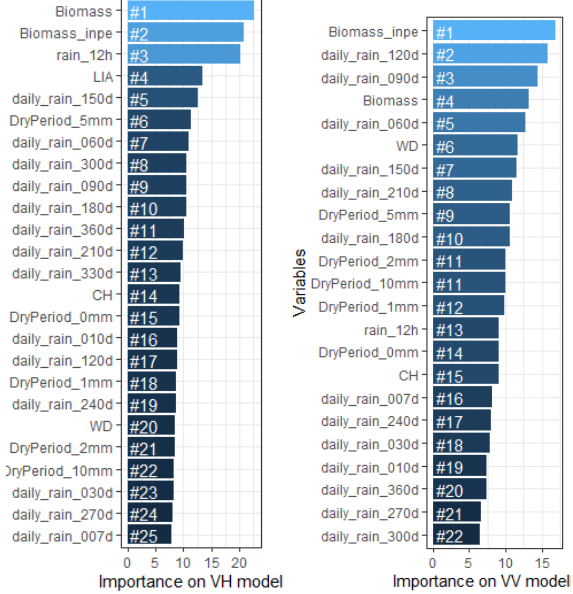
Figure 5. Relative importance of the predictors used on the final random forests models for VH (left) and VV (right) backscattering. Biomass: WHRC AGB datatet. Biomass_inpe: AGB EBA dataset. LIA: Local Incidence Angle.